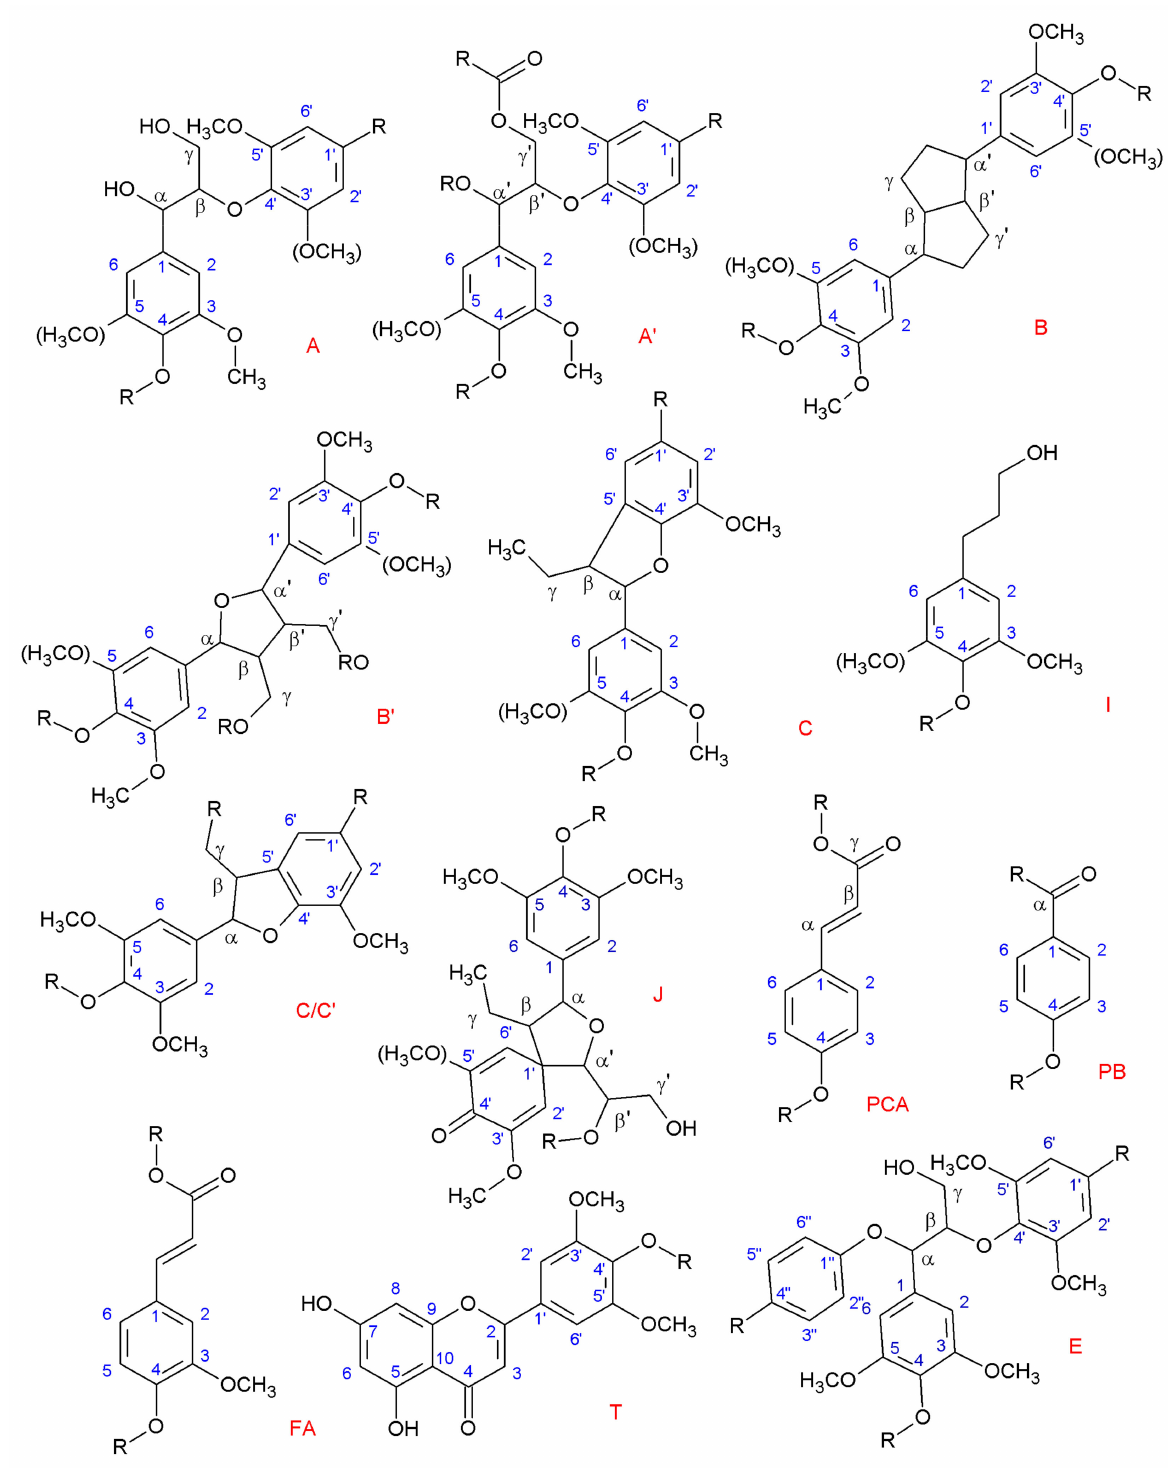
Figure 3. Main lignin structures identified by NMR. (R may indicate both aliphatic and aromatic chains.) (A) β -O-4 alkyl-aryl ethers; (A’) β -O-4 alkyl-aryl ethers with acylated γ ’-OH with p-coumaric acid; (B) resinols; (B’) di-c-acylated mono-tetrahydrofuran structure formed by β – β ’ coupling and subsequent a-O-a’ bonding (R, acetyl/p-coumaroyl); (C) phenylcoumarans; (I) p-hydroxycinnamyl alcohol end-groups; (C/C’) γ -acetylated phenylcoumaran (R, acetyl) (J) spirodienones ( β -1 (cid:48) ); (PCA) p-coumarates; (PB) p-hydroxybenzoate; (FA) ferulates; (T) tricin incorporation into the lignin polymer through a G-type β -O-4 linkage; (E) α , β -diaryl ethers ( α -O-4/ β